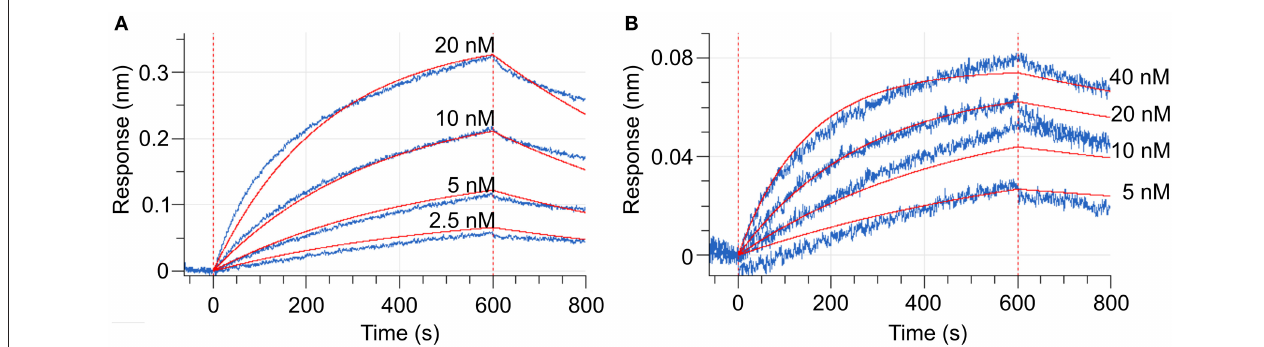
FIGURE 6 | Biolayer interferometry (BLI) curves (baseline, association, dissociation, marked by vertical red dashed lines). (A) Shows the interaction between MtCRE1-IC and MtHPt1 in the presence of 2mM MgCl 2 and 0.5mM ATP. The corresponding K d value is 12 ± 0.06nM. In the measurement, the MtHPt1 protein with N-terminal His-tag and MBP fusion was immobilized on Ni-NTA sensor at a concentration of 104nM (6.3 µ g/mL). The four MtCRE1-IC concentrations used in each BLI experiment were 2.5, 5, 10 and 20nM. Each measurement included a parallel reference in which the sensors were immersed in the BLI buffer only to monitor and subtract unspecific ligand binding effect to the sensor. (B) Illustrates BLI curves for the interaction between MtCRE1-IC and MtHPt1 without ATP and MgCl 2 . The signal level is significantly lower despite the higher concentration of analyte.